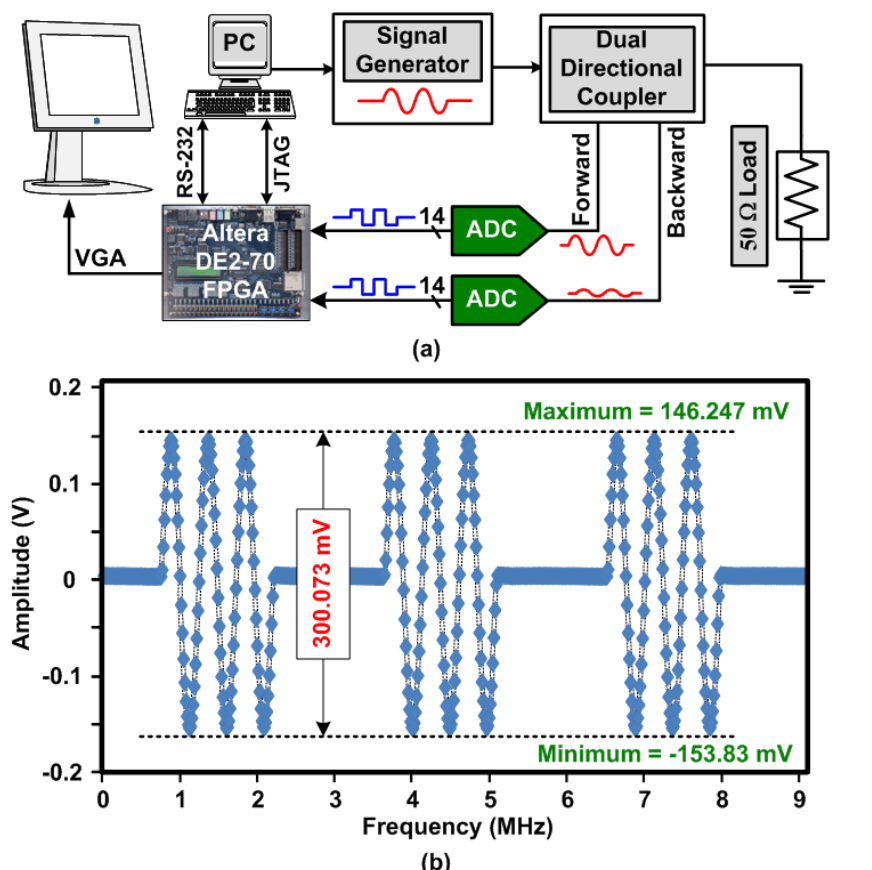
Figure 3. (a) FPGA based power meter block diagram. (b) An example of the sampled forward voltage waveform of a 2 MHz signal applied in a burst of 3 pulses with a burst period of 3 